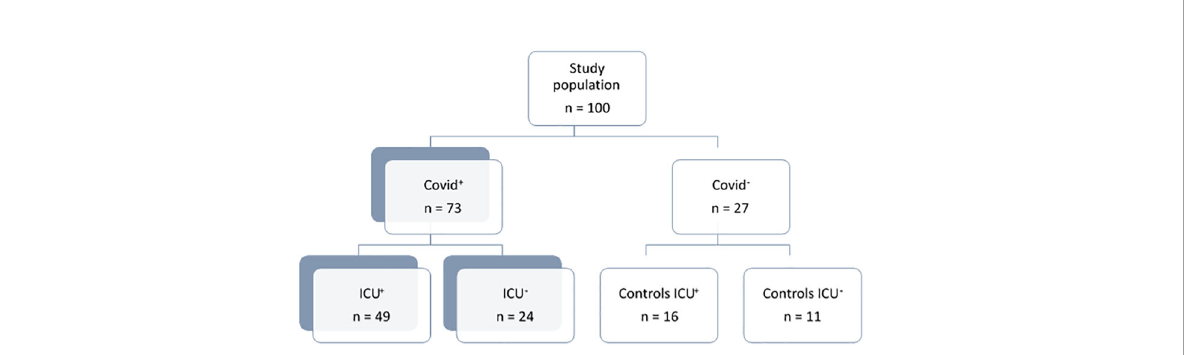
FIGURE 1 Flow chart of the study. Study participants (n=100) were screened for participation during the fi rst surge of the disease (March to May 2020) among 547 patients admitted for COVID either to the emergency department or to the ICU. Informed consent for participation was obtained in 49 COVID+ ICU+ patients, and in 24 COVID+ICU- patients, which were then admitted to the infectious disease department. In parallel, 11 participants were recruited in our staff (as healthy controls, COVID-ICU-), and so were 16 COVID-ICU+ patients that were admitted for non- COVID multiple organ failure requiring mechanical ventilation